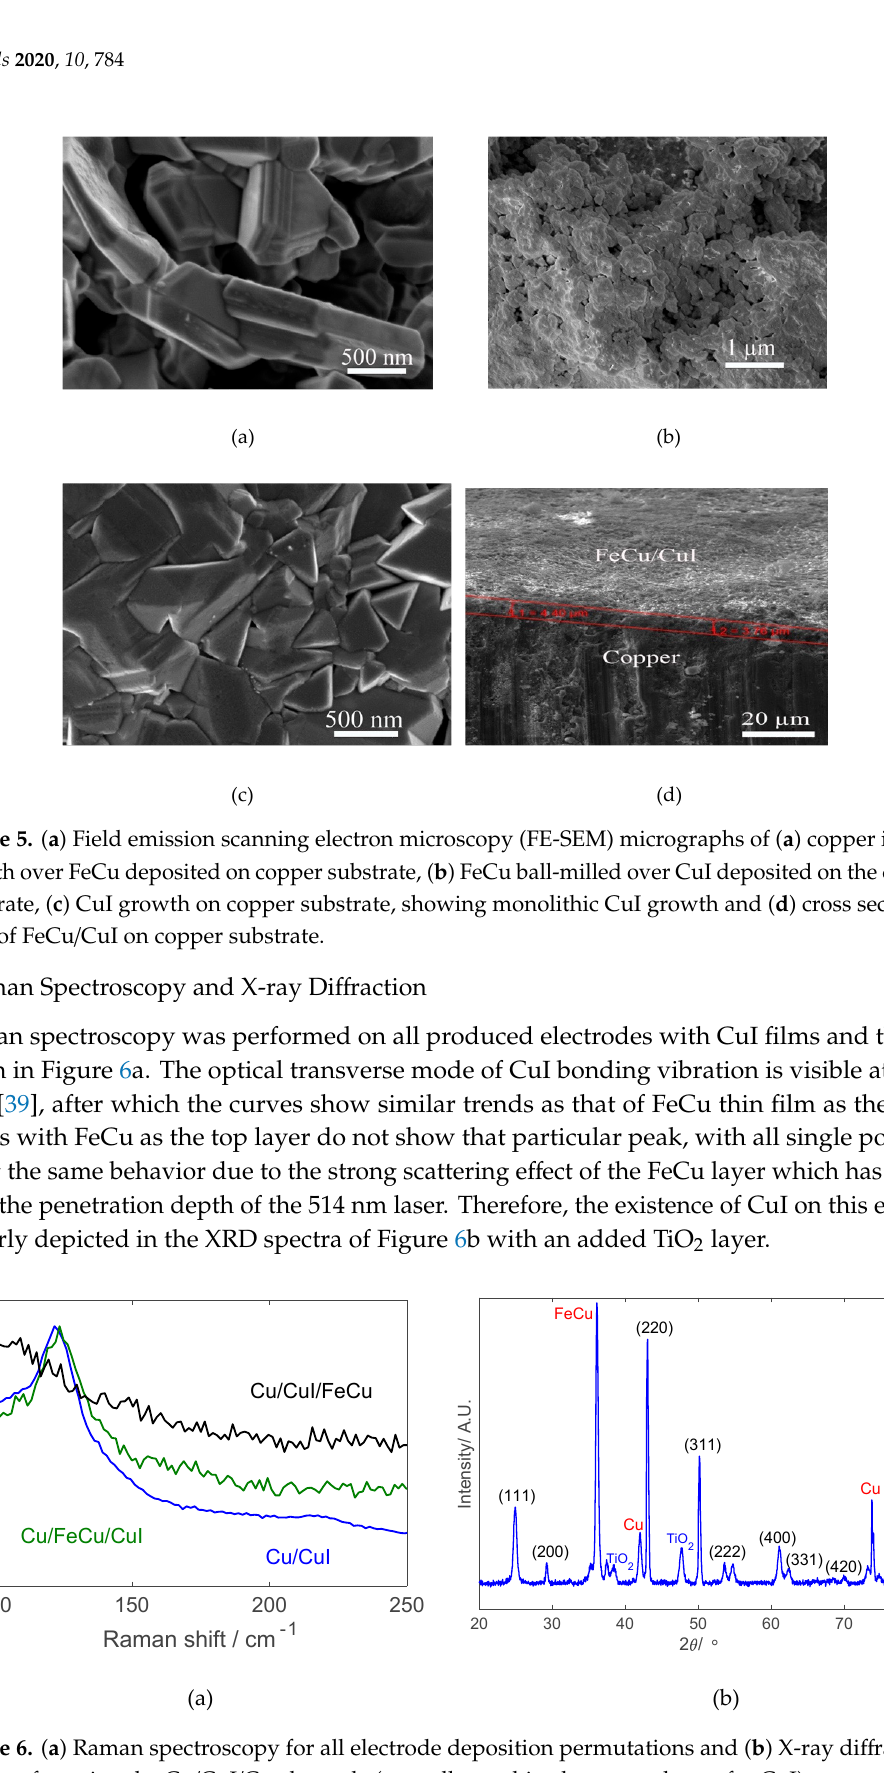
(b) Figure 7. ( a ) Spectral absorptivity of produced electrodes and ( b ) FTIR spectra of the natural Calotropis dye. The FTIR spectra shown in Figure 7 (b) fall within the wave band of 4000~500 cm − 1 . The figure identifies the functional groups present in the examined dye samples. The obtained spectrum is in agreement with that found in the literature for chlorophyll extracts. Natural dyes are known to be